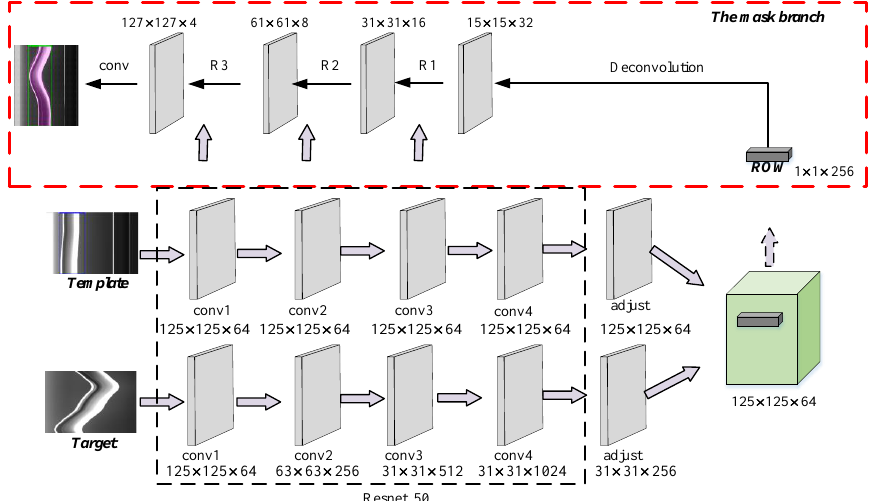
Figure 7. The architecture of the Siamese neural network.